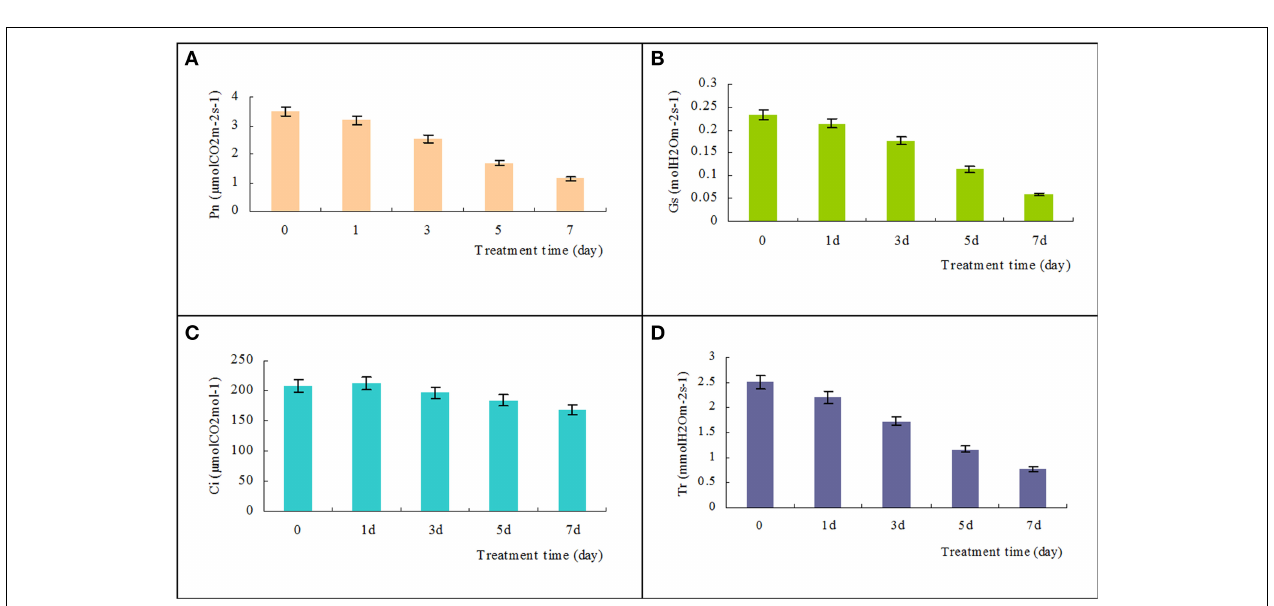
FIGURE 4 | Effects of high salinity on the net photosynthetic rate (Pn), stomatal conductance (Gs), intercellular CO 2 (Ci), and transpiration rate (Tr). Changes in Pn, Gs, Ci, and Tr in T. Nitraria seedling leaves after treatment with 500mM NaCl for 0, 1, 3, 5, and 7 days were determined using the